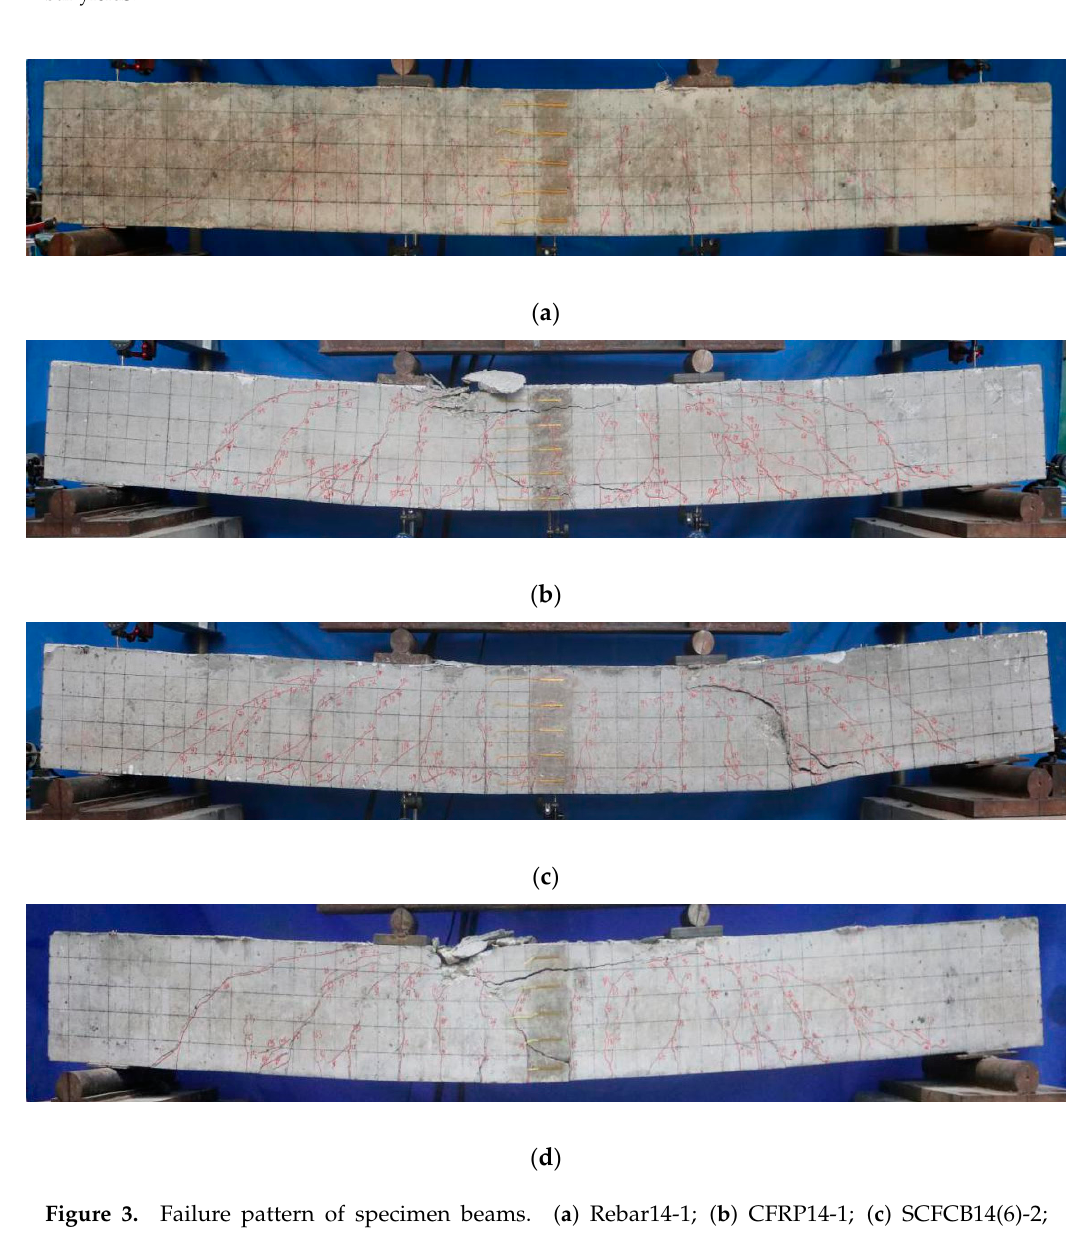
Figure 3. Failure pattern of specimen beams. ( a ) Rebar14-1; ( b ) CFRP14-1; ( c ) SCFCB14(6)-2; ( d ) SCFCB14(8)-2.